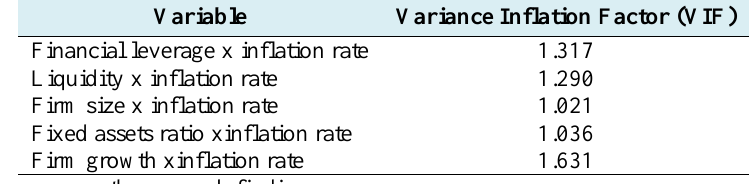
Table 9. The results of testing the absence of multicollinearity among explanatory variables in model (2) in the TSE